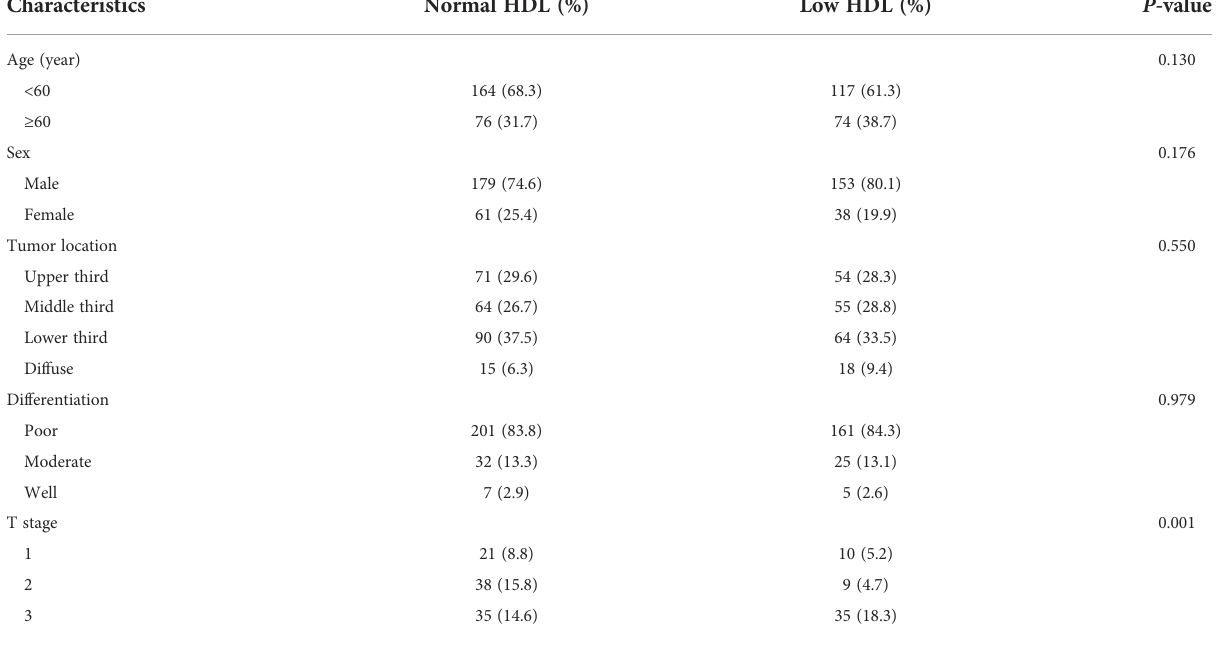
TABLE 5 Characteristics of the normal-HDL and low-HDL groups in 431 patients (after surgery).